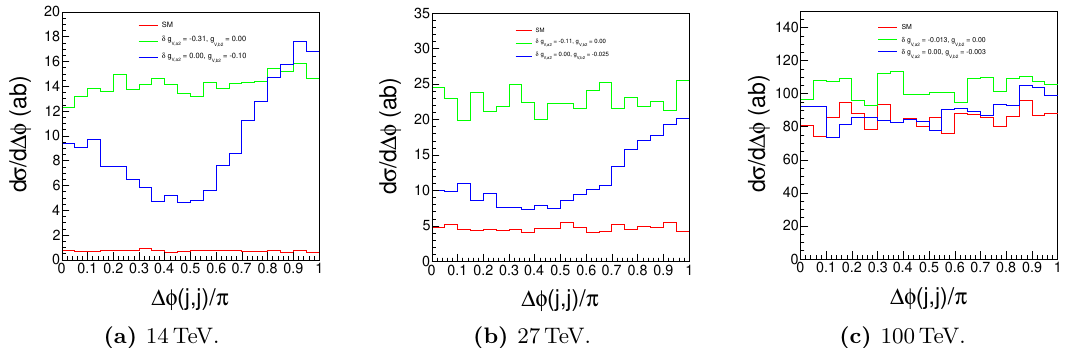
Figure 9 . The relative azimuthal angle distributions of two forward jets for 14 TeV, 27 TeV, and 100 TeV.